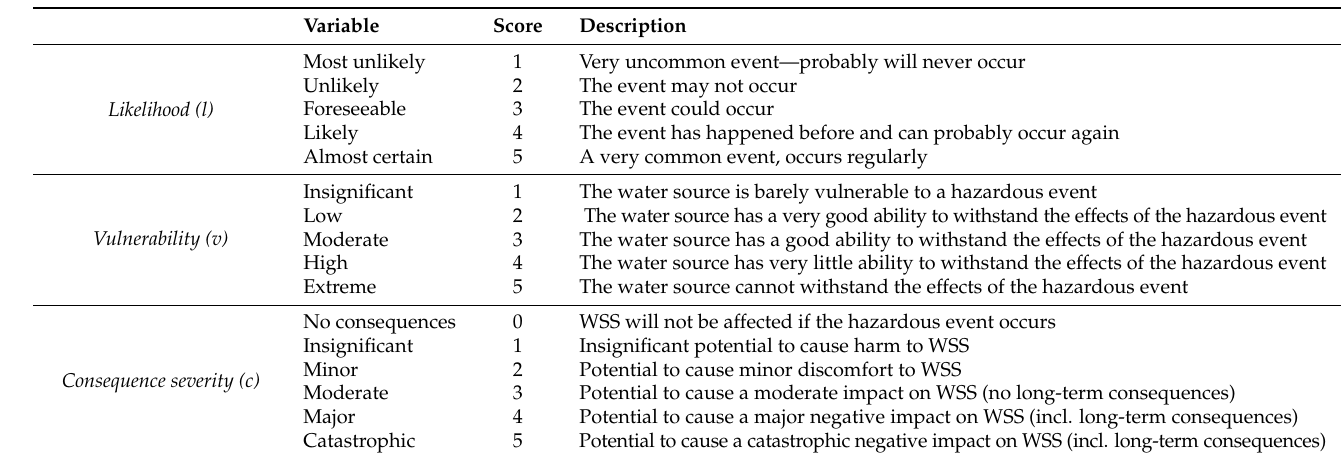
Table 5. Description of likelihood, vulnerability, and consequence severity classes and their respective